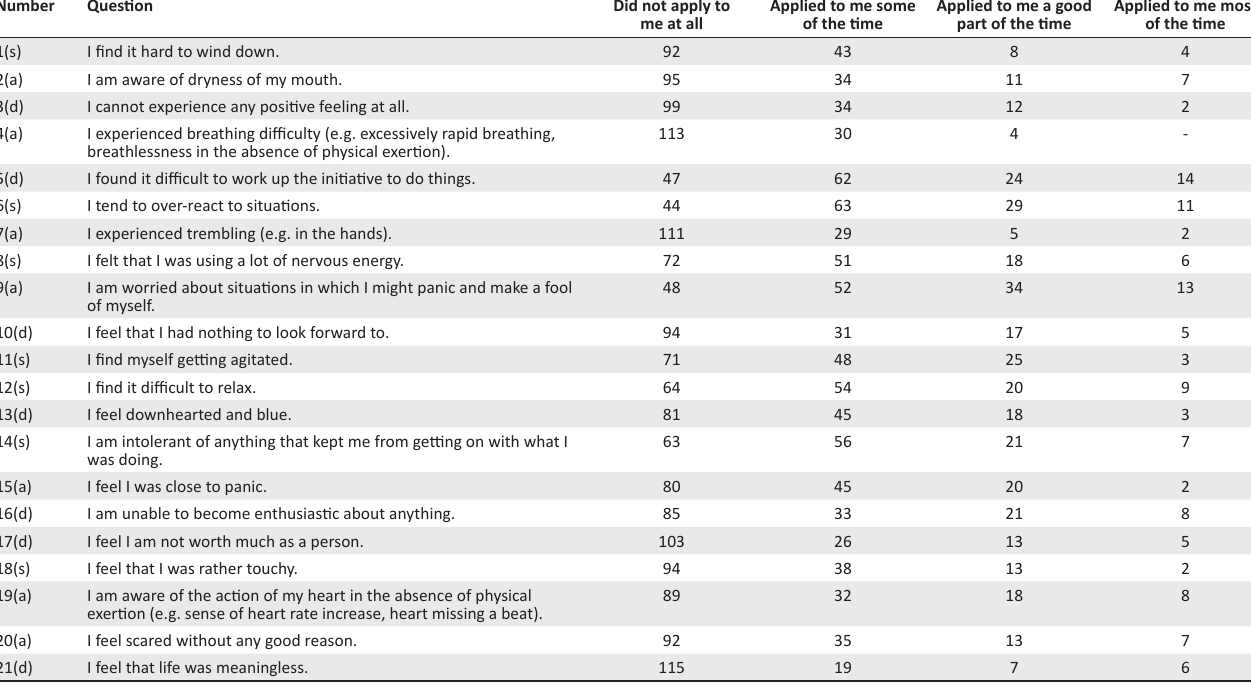
FIGURE 1: Severity levels for depression, anxiety and stress subscales in participants ( n = 147) as measured using the Depression Anxiety Stress Scale-21 questionnaire. TABLE 1: Frequency of responses for the questions in the DASS-21